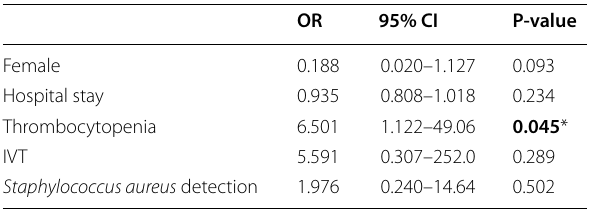
Table 4 Intracranial hemorrhage, multivariate logistic